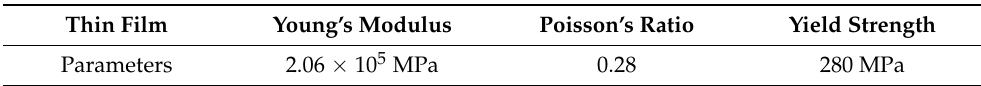
Table 1. Constitutive parameters of thin film.